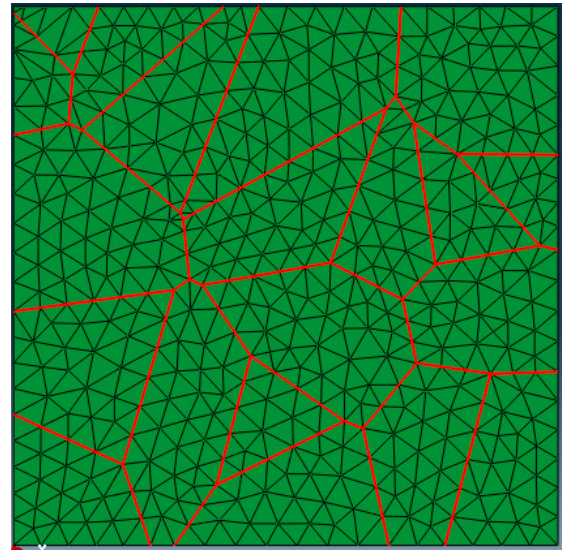
Figure 7. The mesh developed for the polycrystalline case study.